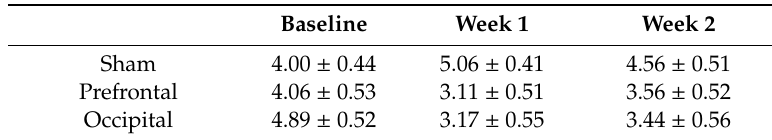
Table 3. Summary statistics of the number of migraine days per week in the three brain stimulation conditions at baseline, week 1, and week 2.